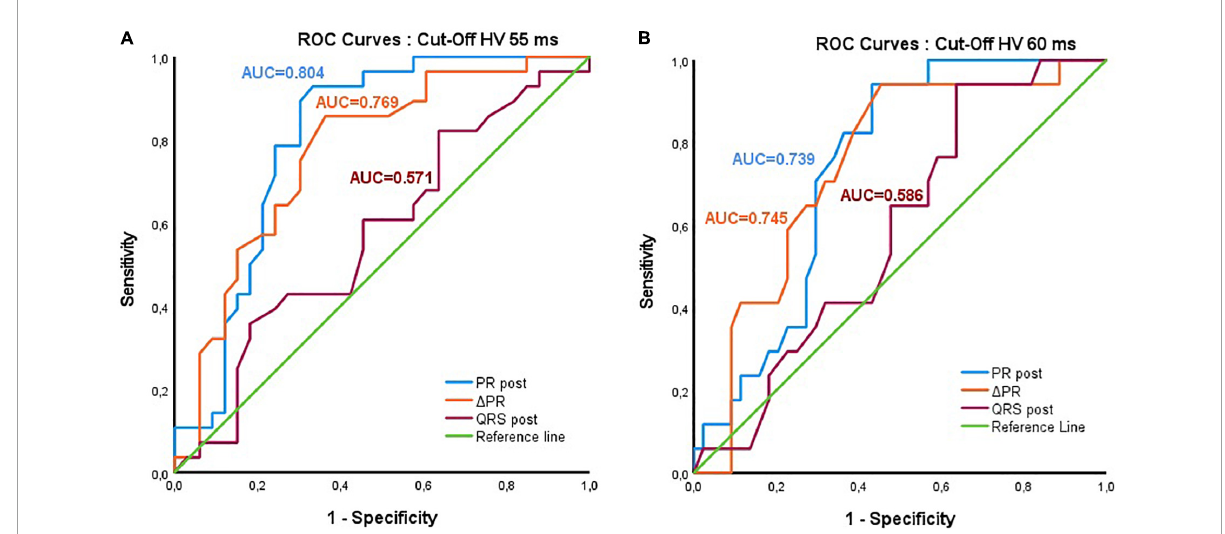
FIGURE1 ROC curves for PR, (cid:49) PR and QRS intervals to discriminate patients with abnormal HV after transcatheter aortic valve replacement: (A) HV interval cut-off 55 ms; (B) HV interval cut-off 60